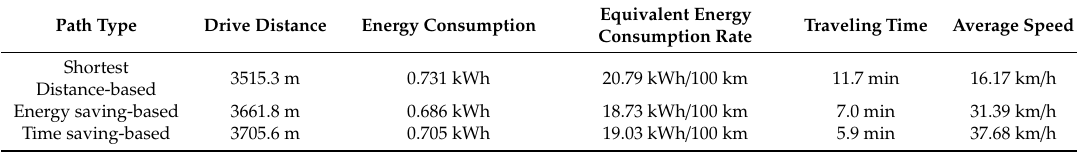
Table 8. The optimal results for di ff erent optimization